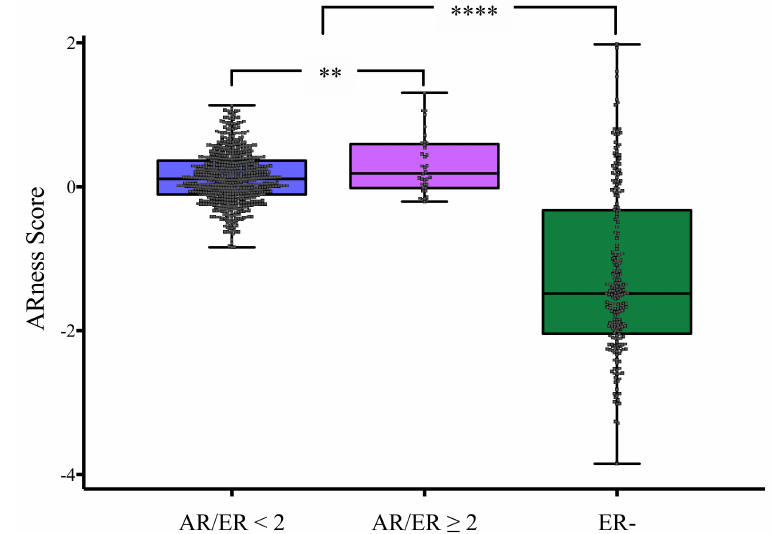
Figure 4. AR-ness signature in BC cases from GDC, grouped by AR / ER ratio. Higher AR-ness score in AR / ER ≥ 2 group indicates a more active AR signaling respect to cases in other groups. ER-: estrogen receptor negative cases. Kruskal–Wallis H test - ** P = 0.004, **** P = 8.65 × 10 − 28